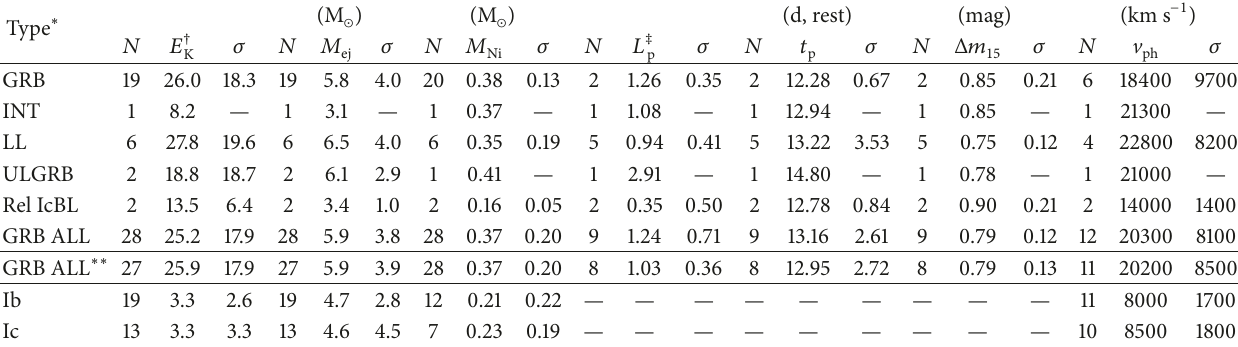
Table 1: Average Bolometric properties of